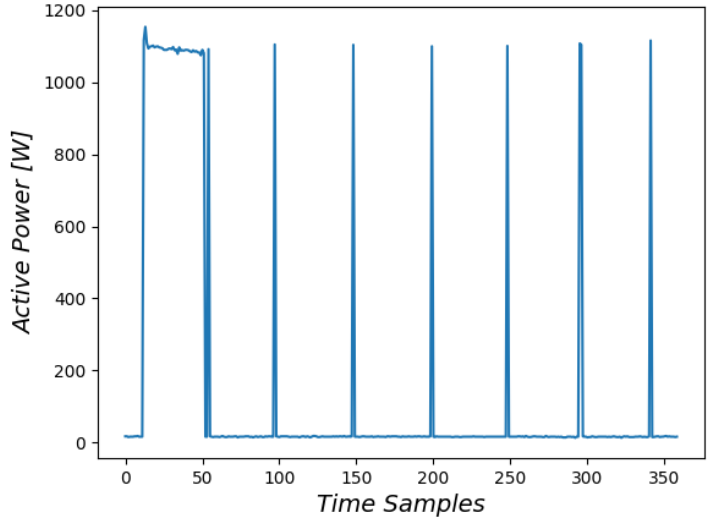
Figure 2. Example of operation cycle of Type II appliance that can be modeled as a series of turn-on and turn-off events. This device’s symbol is WOE in the AMPds dataset.